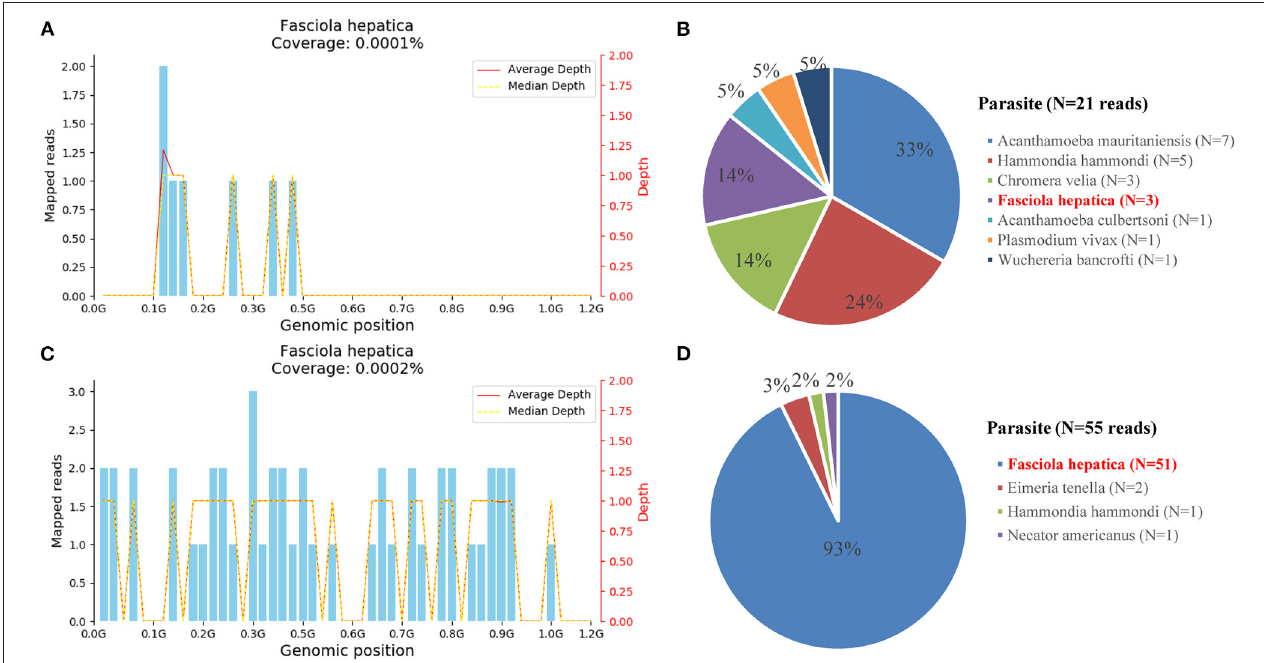
FIGURE 4 | Diagnosis of Fasciola hepatica infection using metagenomic next-generation sequencing (mNGS). (A) The reads mapped to the Fasciola hepatica genome with coverage of 0.0001% in the liver tissue. (B) The distribution of species-specific reads aligning to the parasite in the liver tissue. (C) The reads mapped to the Fasciola hepatica genome with coverage of 0.0002% in the blood. (D) The distribution of species-specific reads aligning to the parasite in the blood.